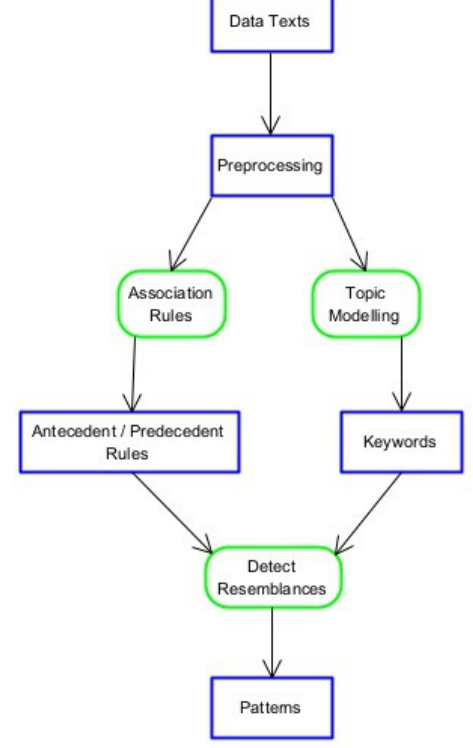
Figure 1: The proposed process that combines topic modeling and association rule mining to extract semantic